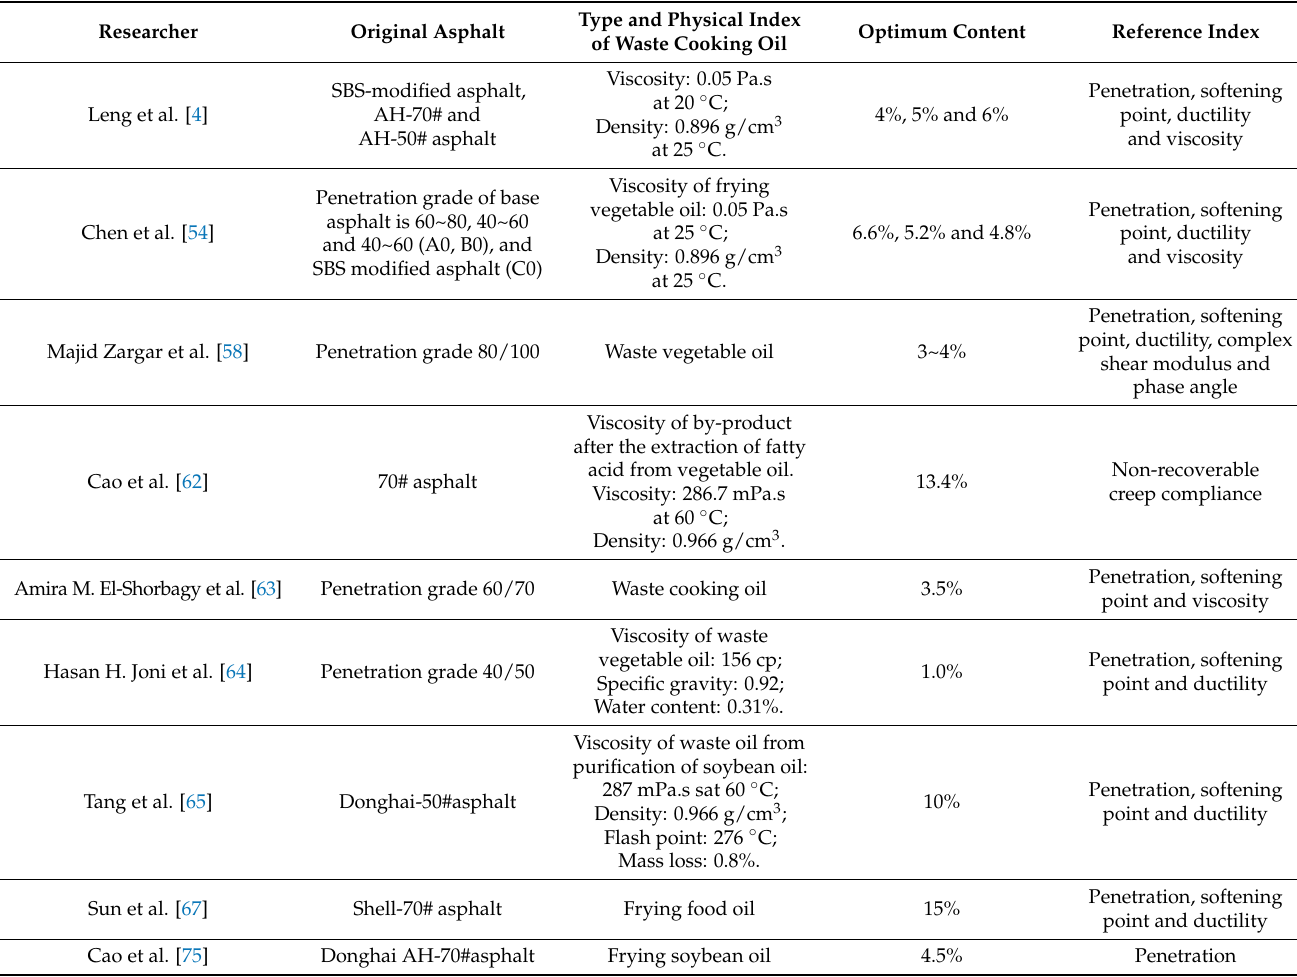
Table 14. Optimum content of waste cooking oil in aged asphalt.